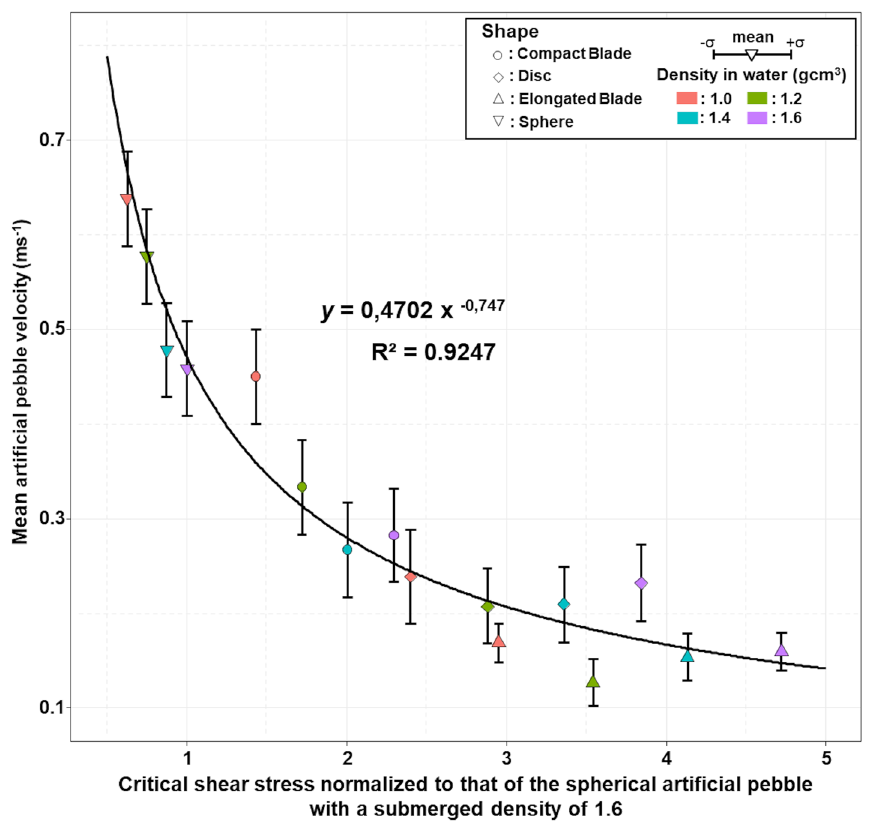
Figure 5. Mean velocity of the 16 artificial pebbles vs. their critical shear stress normalized to that of the spherical artificial pebble with a submerged density of